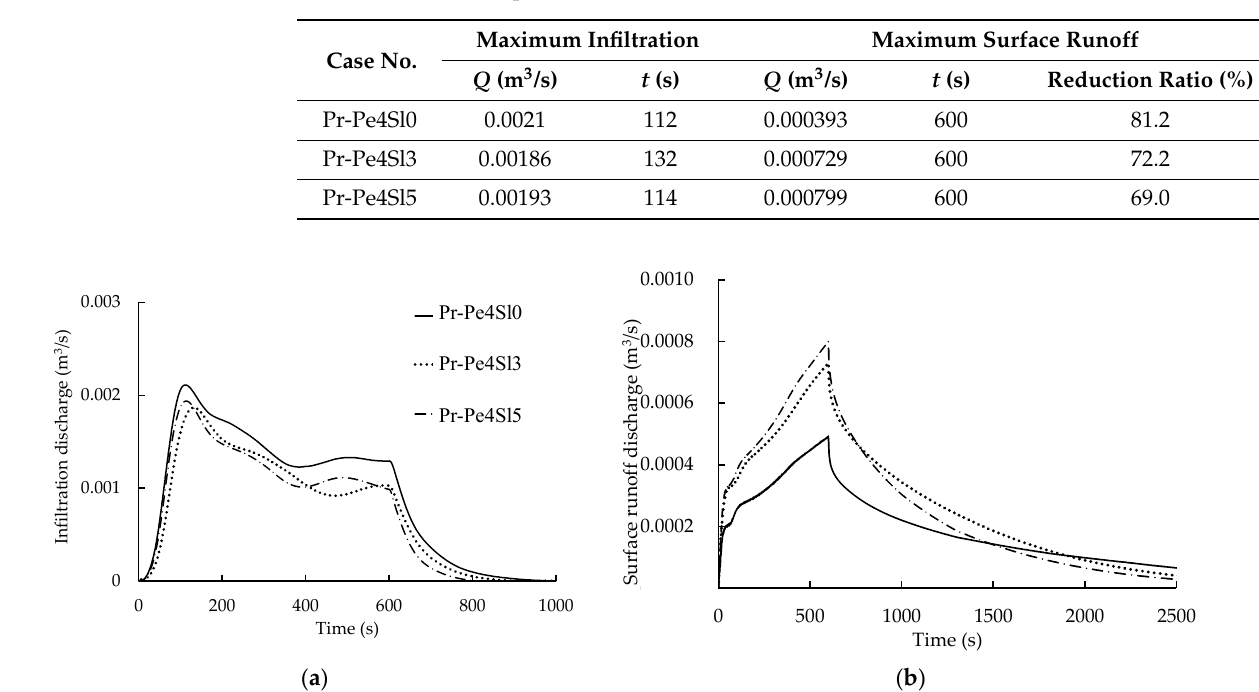
Figure 18. Comparison of slope variation: ( a ) infiltration; ( b ) surface runoff.